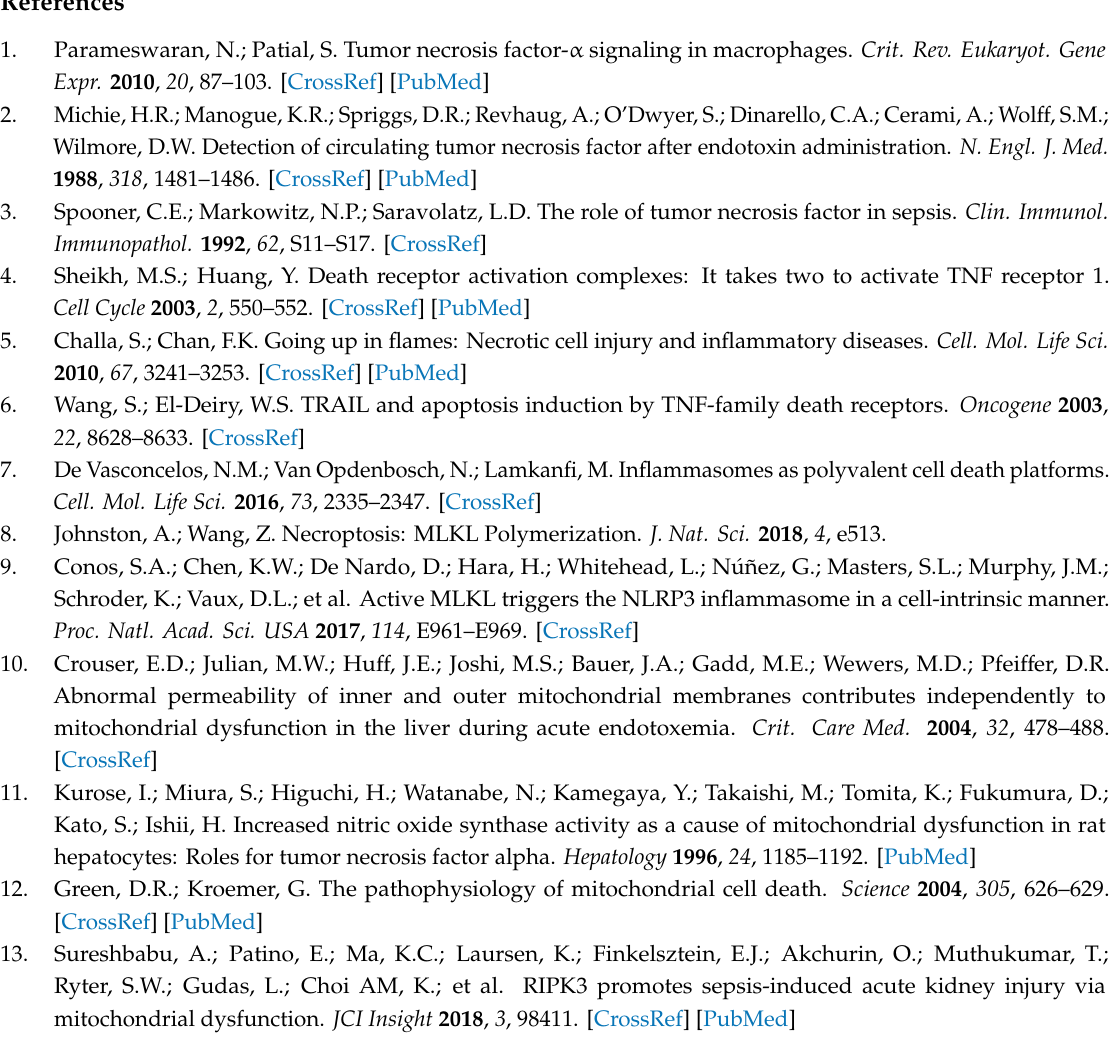
Figure S1. E ff ects of SEM18 peptide on mitigating interleukin-1 β (IL-1 β ) upregulation in primary hepatocytes treated with tumor necrosis factor- α (TNF- α